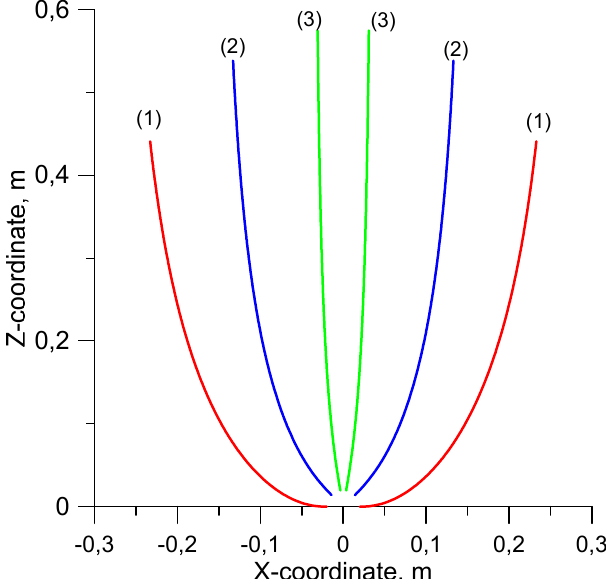
Figure 2. The path of the streamer channels leaving the tip of the rod, which is formed as a hemisphere, at different polar angles. The path marked (1) is taken by the streamers leaving the equator of the hemisphere (polar angle 90 degrees). The curves marked (2) and (3) correspond to the paths of streamers leaving the hemisphere with polar angles of 45 and 10 degrees. Observe that zero degree corresponds to the streamer leaving from the top of the hemisphere. Note that what is depicted is the cross section of the three-dimensional streamer zone, which is symmetric around the central axis. The height of the grounded rod is 2.5 m, the radius of the rod is 2 cm and the value of the (vertical) background electric field is 100